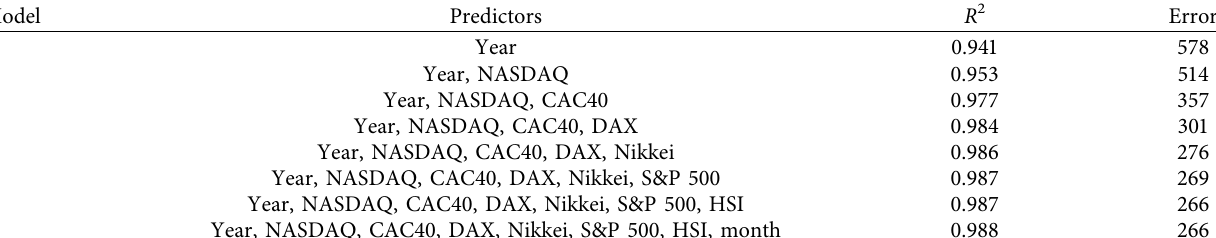
Table 6: Stepwise linear regression models using general index based on international indices and date without using a constant.